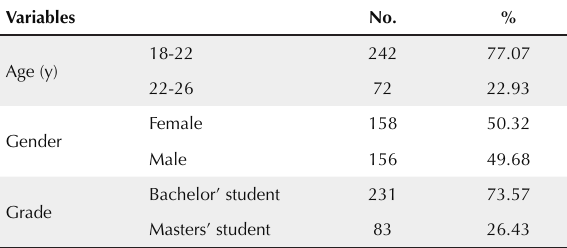
Table 1. Demographic variables of the participants Variables